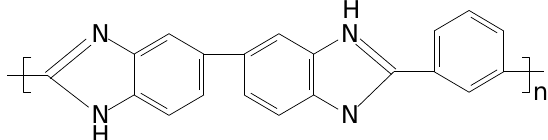
Figure 1. Chemical structure of poly[2,2 (cid:48) -(m-phenylen)-5,5 (cid:48) -bisbenzimidazole] (PBI).